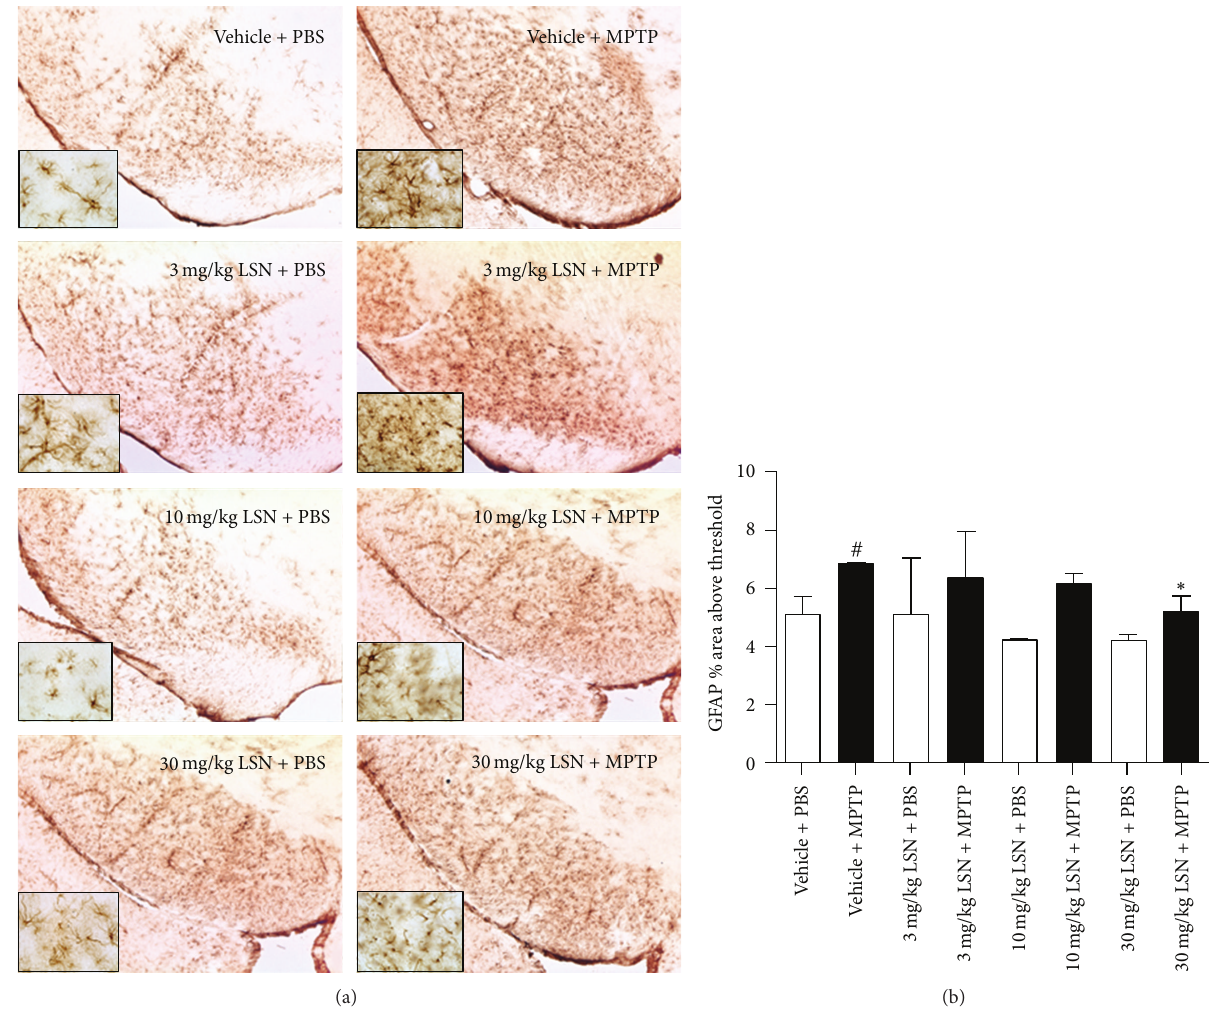
Figure 6: LSN862 (LSN) inhibited MPTP-mediated astrogliosis. Mice brains were evaluated 21 days after completing MPTP challenge and 24 hrs after daily treatment with LSN. (a) Images at the level of the substantia nigra (SN) immunostained for GFAP. Insets correspond to high magnification images. Scale bar: low magnification = 100 𝜇 m, high magnification = 25 𝜇 m. (b) Quantification of nigral GFAP immunoreactivity (means ± SEM; 𝑛 = 4 – 7 per group); ANOVA (Fisher’s LSD post hoc), # 𝑃 < 0.05 (vehicle + PBS versus vehicle + MPTP), ∗ 𝑃 < 0.05 (vehicle + MPTP versus 30mg/kg LSN +